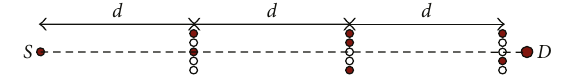
Figure 2: Approximation solution.